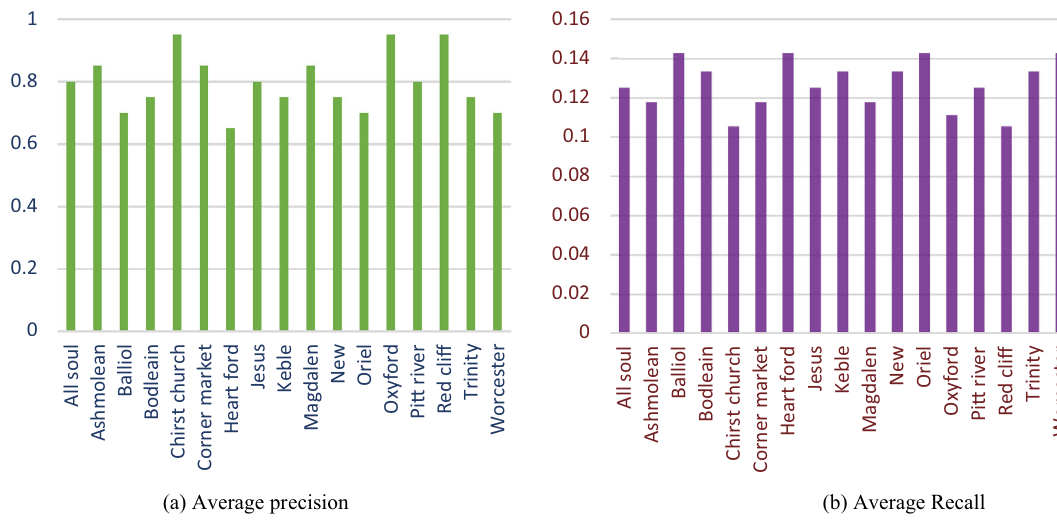
Fig. 15 a Average precision. b Average recall